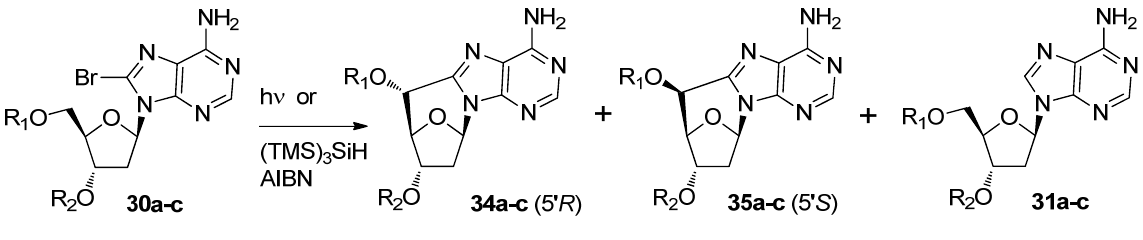
Scheme 9. The effects of reagents, solvents, and protecting groups in the stereochemistry of radical cascade cyclization.